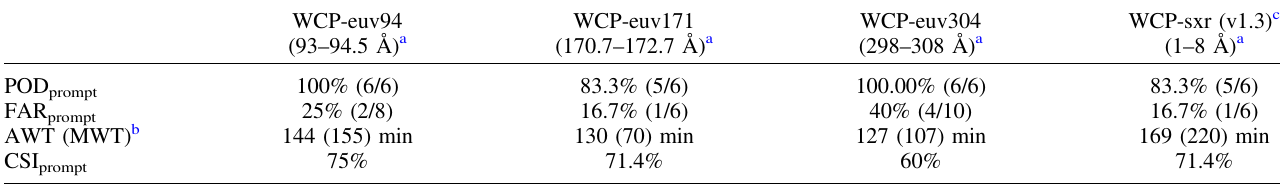
Table 8. Forecasting results of the WCP-euv94, WCP-euv171, WCP-euv304 and WCP-sxr (v1.3) models using out-of-sample data for predicting the SEP events in Table 1, which occurred from November 2014 to December